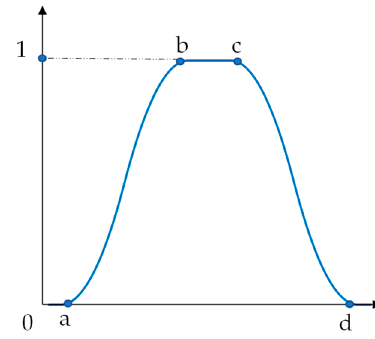
9 of 25 Figure 3. The shape of the MF (Gaussian FN). Pi FN, defined as Fn Pi = ( a , b , c, d ), has its MF given by (3): 𝑚 (cid:3033)(cid:3017)(cid:3036) (cid:4666)𝑥(cid:4667) =